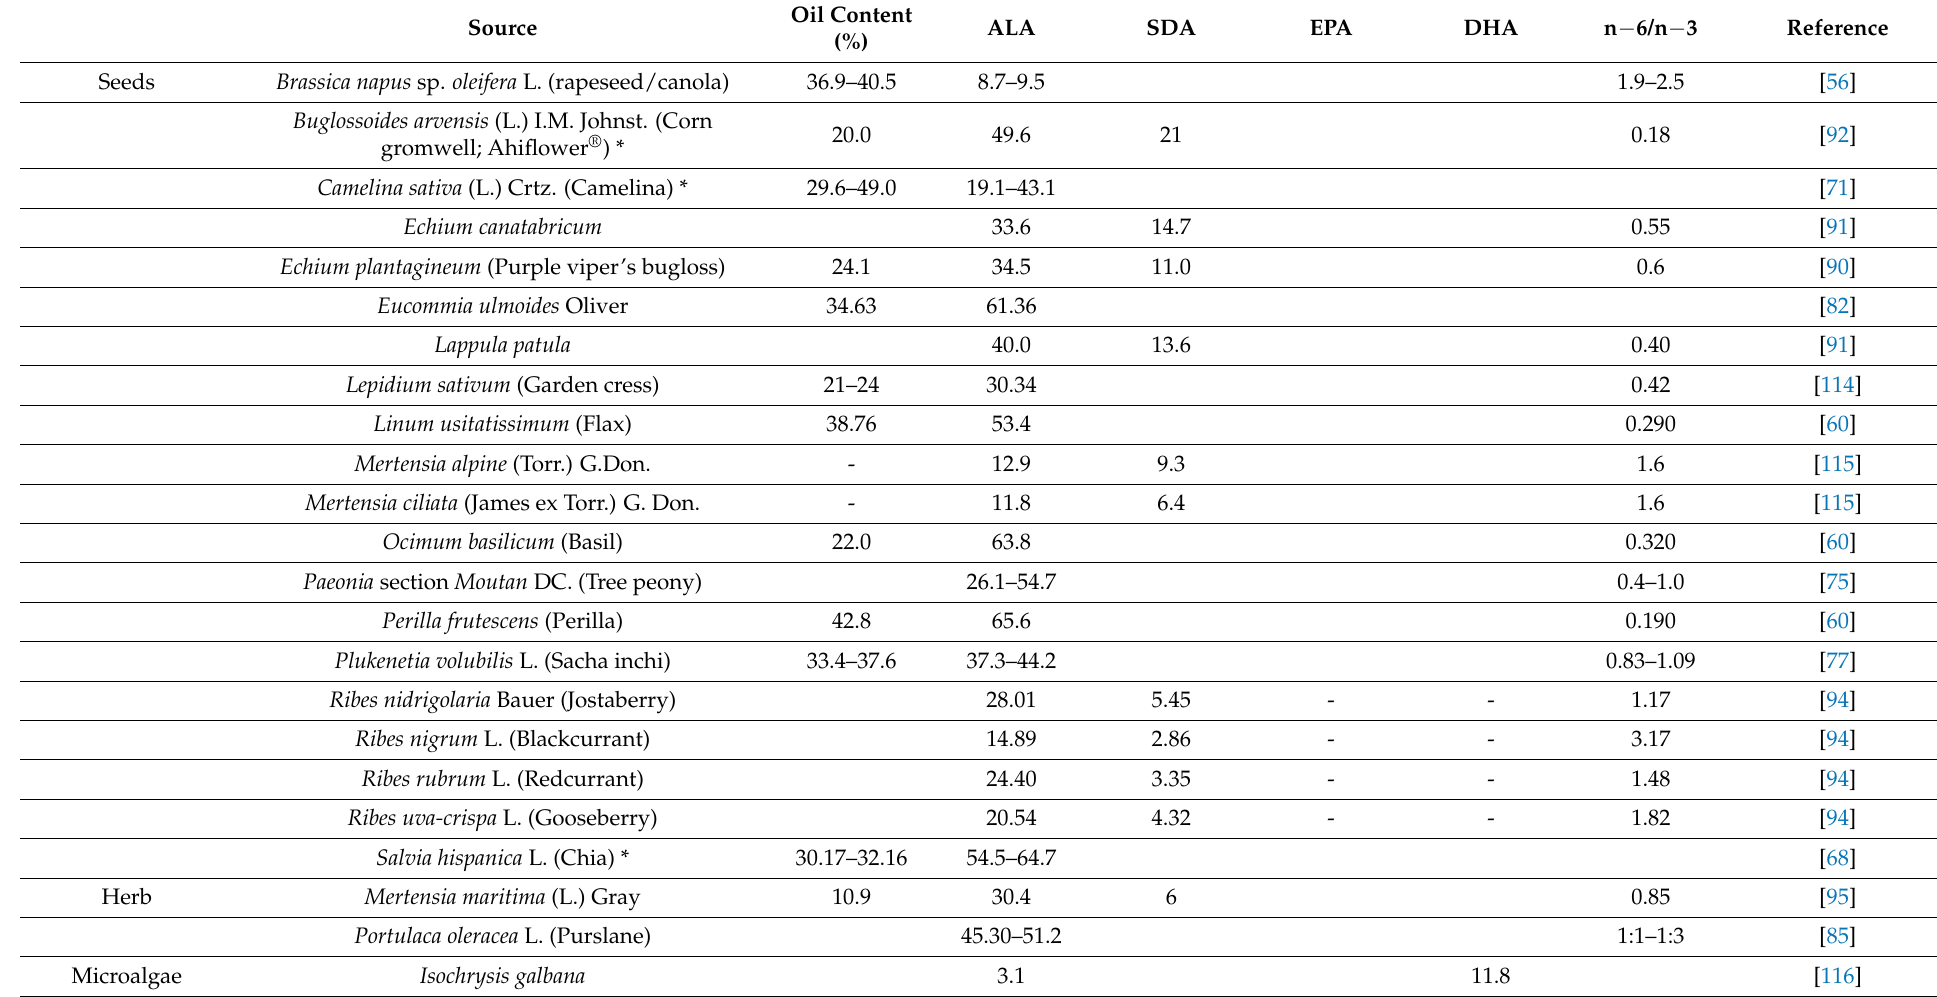
Table 1. n − 3 and n − 6 fatty-acid content in the selected plant and animal-based